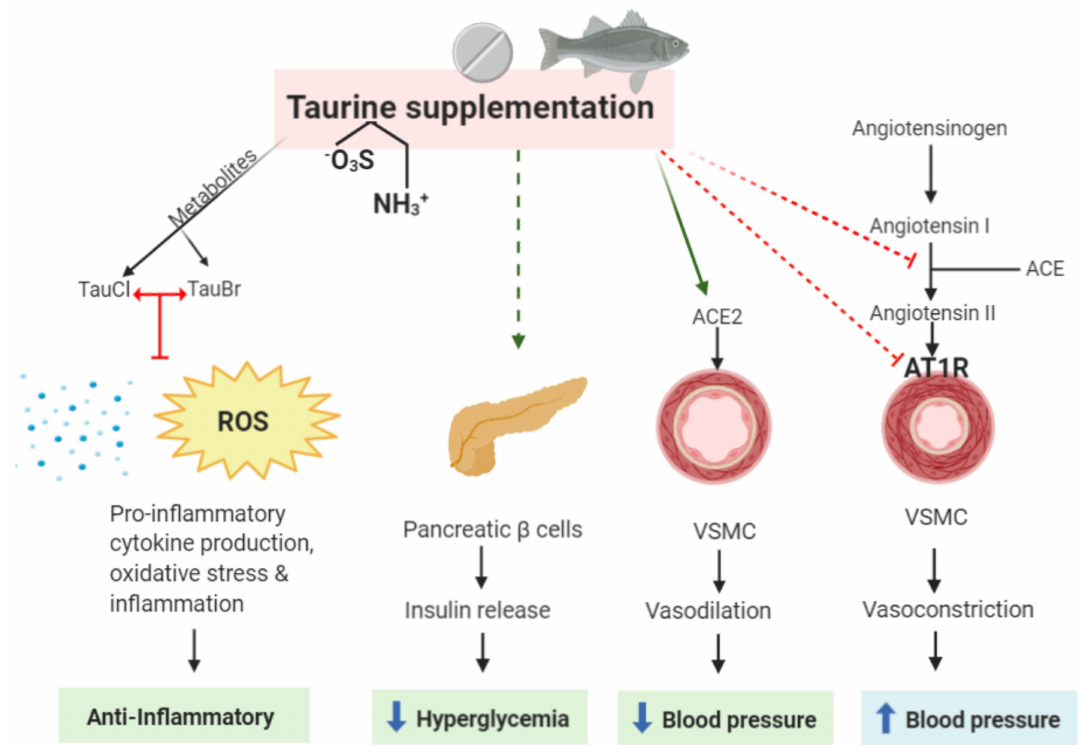
Figure 1. Possible sites of action of taurine as a beneficial agent in treating cardiovascular disease (CVD) and its anti-inflammatory properties. The taurine metabolites, TauCl and TauBr, exert anti-inflammatory properties by blocking the production of pro-inflammatory cytokines, oxidative stress (ROS), and inflammation. Taurine itself may directly reduce hyperglycemia, activate the protective arm of the renin-angiotensin system (RAS) by increasing ACE2 expression, and inhibit the harmful axis of the RAS by reducing Ang II production, which is currently one of the main targets in treating CVD and coronary heart disease (CAD). It must be emphasized that taurine supplementation eliciting insulin release may be detrimental / have no e ff ect in patients who are obese and have already elevated insulin levels. TauCl, taurine-chloramine; TauBr, taurine-bromamine; ROS, reactive oxygen species; VSMC, vascular smooth muscle cell; ACE, angio-converting enzyme; AT1R, AngII type 1